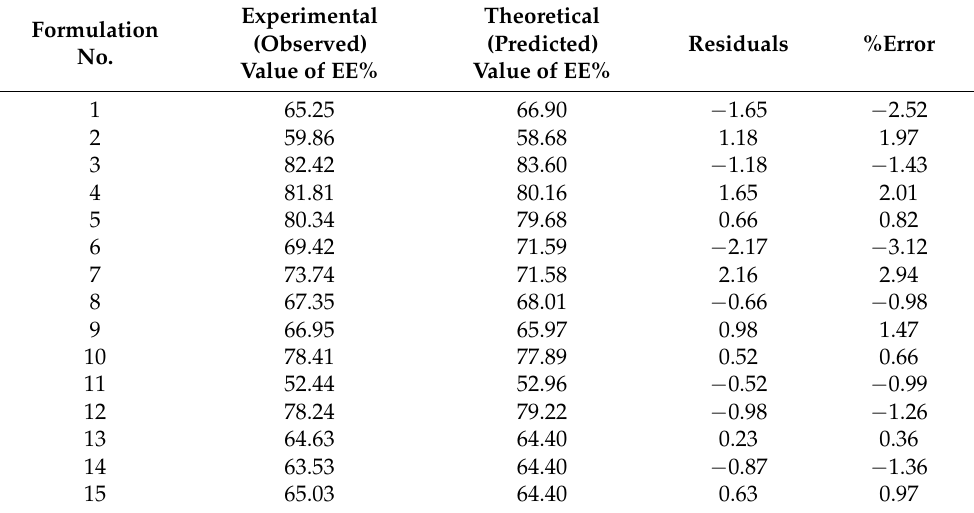
Table 12. Experimental and theoretical values with residuals of the response Y3.